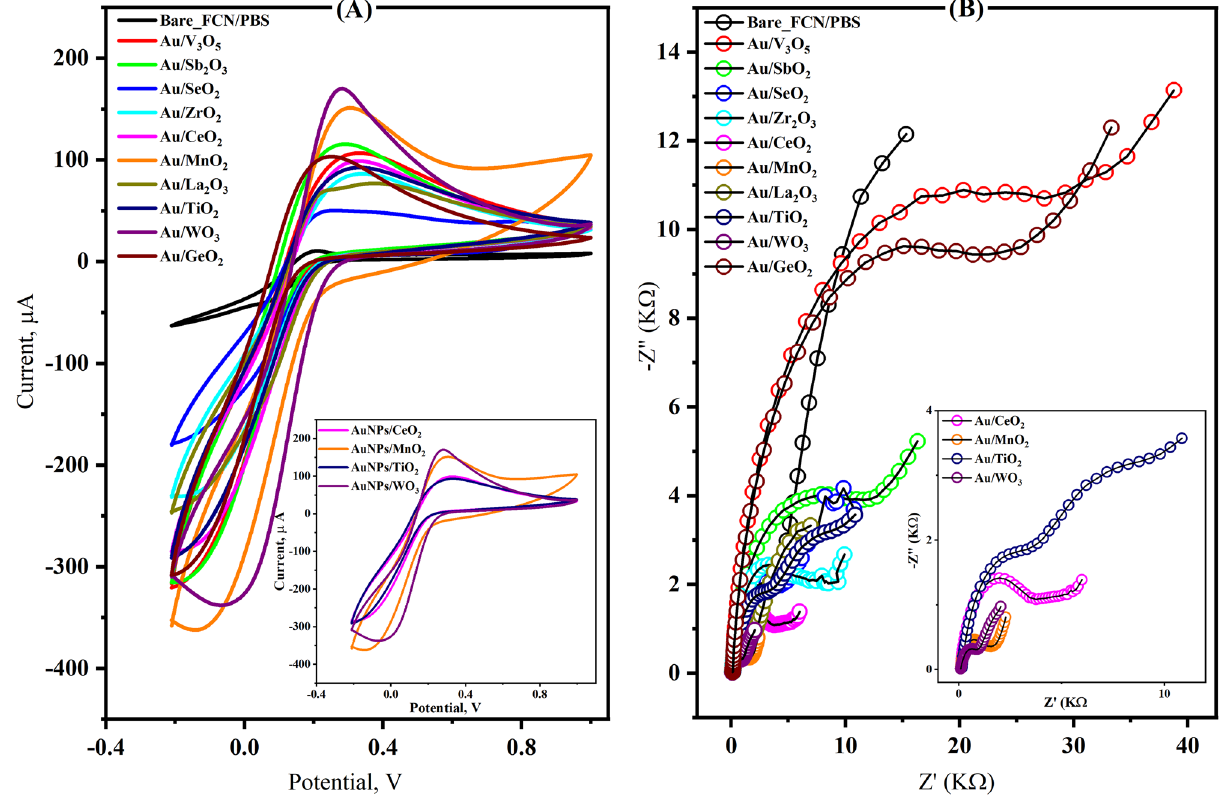
Figure 1. The electrochemical investigations of the AuNPs/metal oxides modified SPEs. The AuNPs/WO 3 showed the highest significant response for electron transfer in FCN/PBS ( A ), and a lower impedimetric response among the other nanomaterials ( B